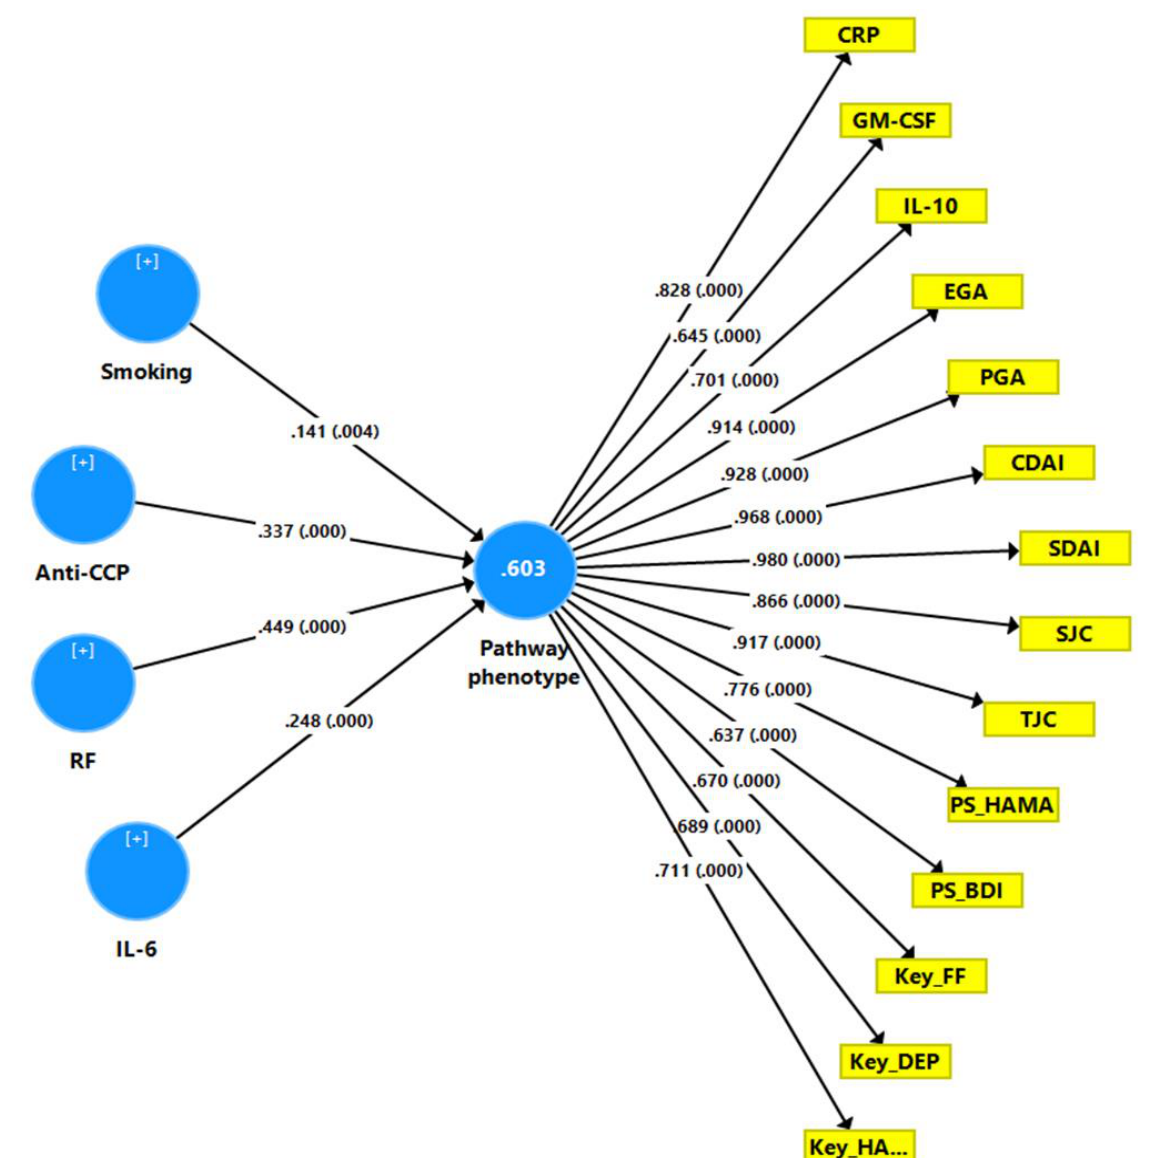
Figure 6. Results of a second Partial Least Squares path analysis, performed to construct a new pathway phenotype.